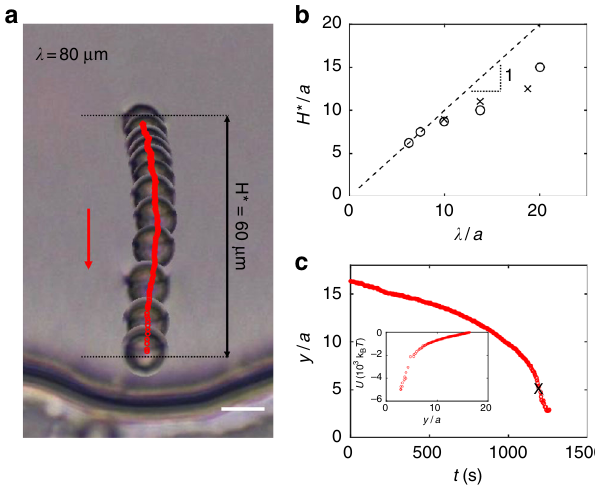
Fig. 2 Colloid-wall interaction range vs. wavelength λ . A ferromagnetic homeotropic colloid with a Saturn ring defect is used to establish the range of interaction H * of the colloid with the wall. a An equal time step ( Δ t = 125 s) image is shown for the case λ = 80 μ m, H * = 60 μ m. b Range of interaction H * vs. the wavelength of the feature λ for homeotropic droplets (open circles) and homeotropic colloids (crosses). c The position of the particle y with respect to time t . Inset: Energy dissipated to viscosity along a particle trajectory U with respect to the particle position y . The cross shows where we truncate the trajectory for integration along the path to infer the dissipation. The scale bar is 10 μ